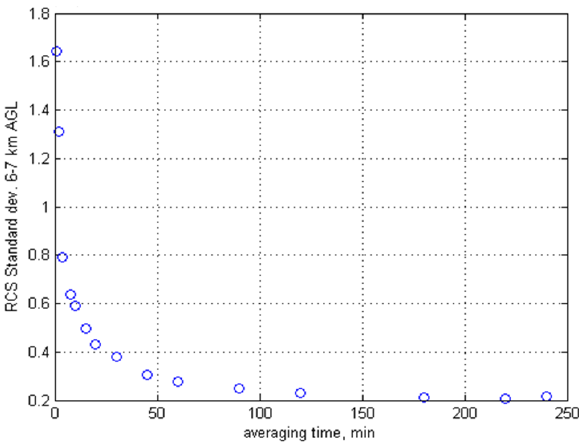
Figure 2. Effects of time averaging on the noise. At 30 (60) min. the 90% (95%) of the lowest standard deviation on the signal is found. The SSD is the average of seven different profiles obtained through- out the day, for different